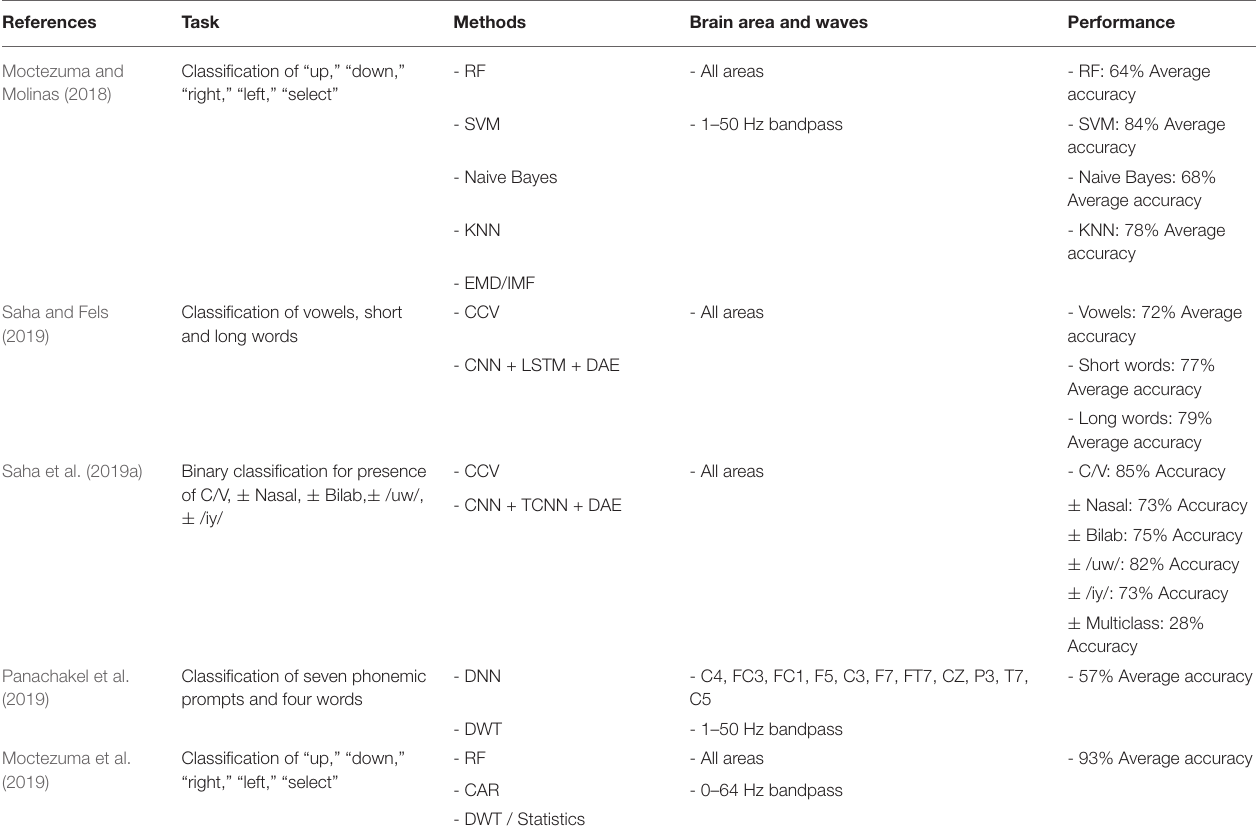
TABLE 4 | Imagined speech classification methods summary